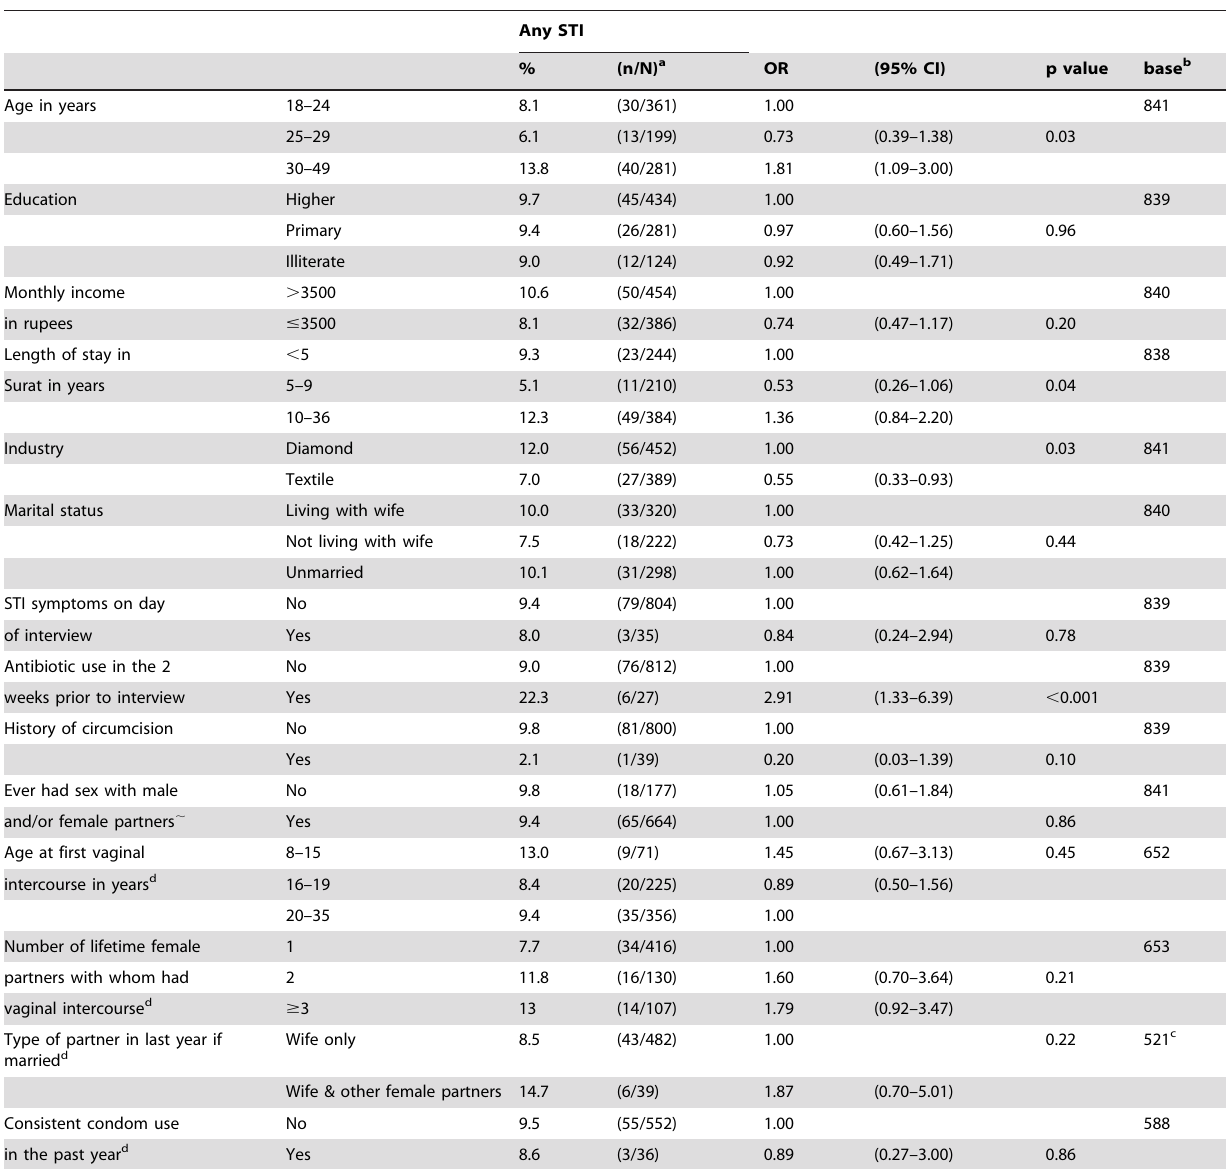
Table 4. Unadjusted association of determinants with ‘any